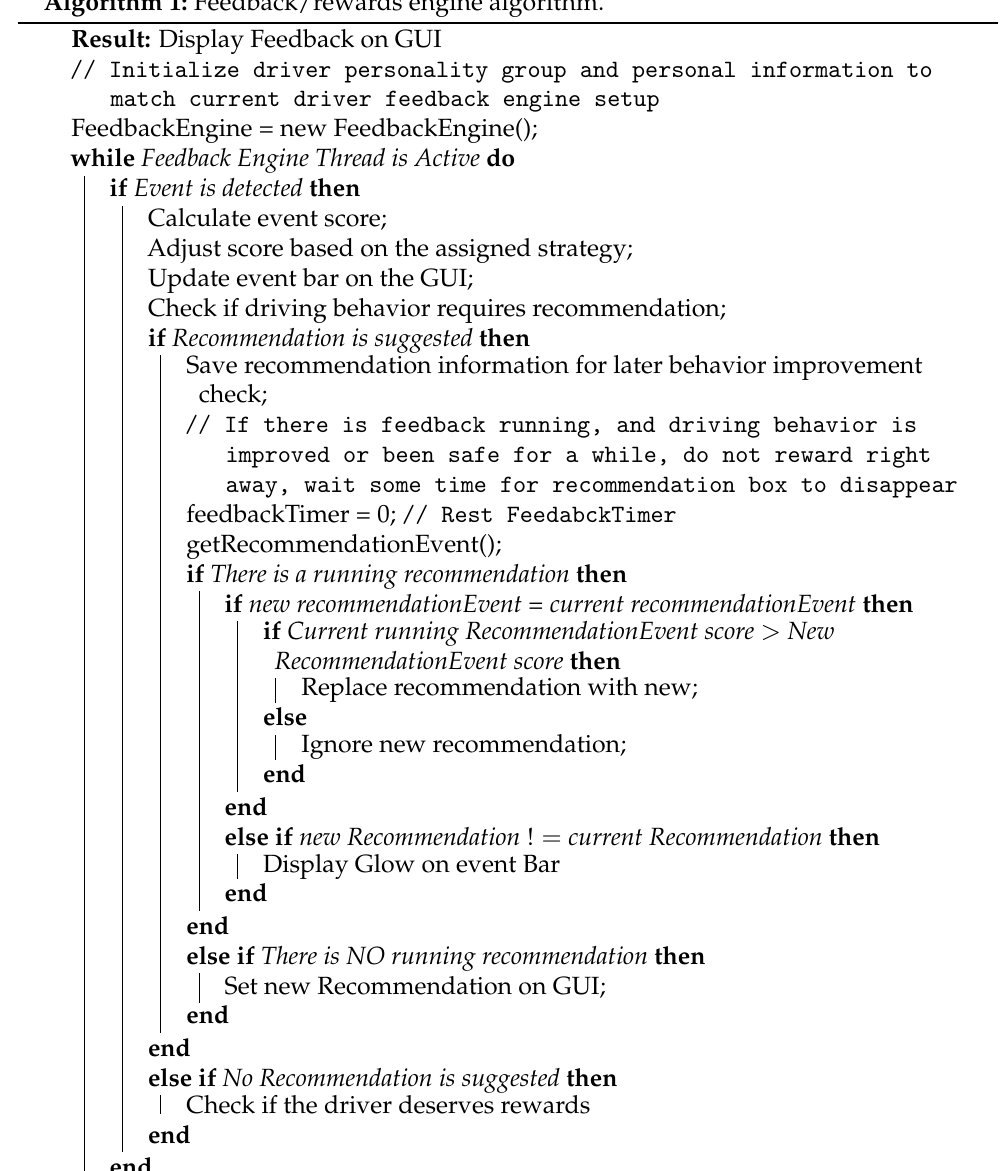
Algorithm 1: Feedback/rewards engine